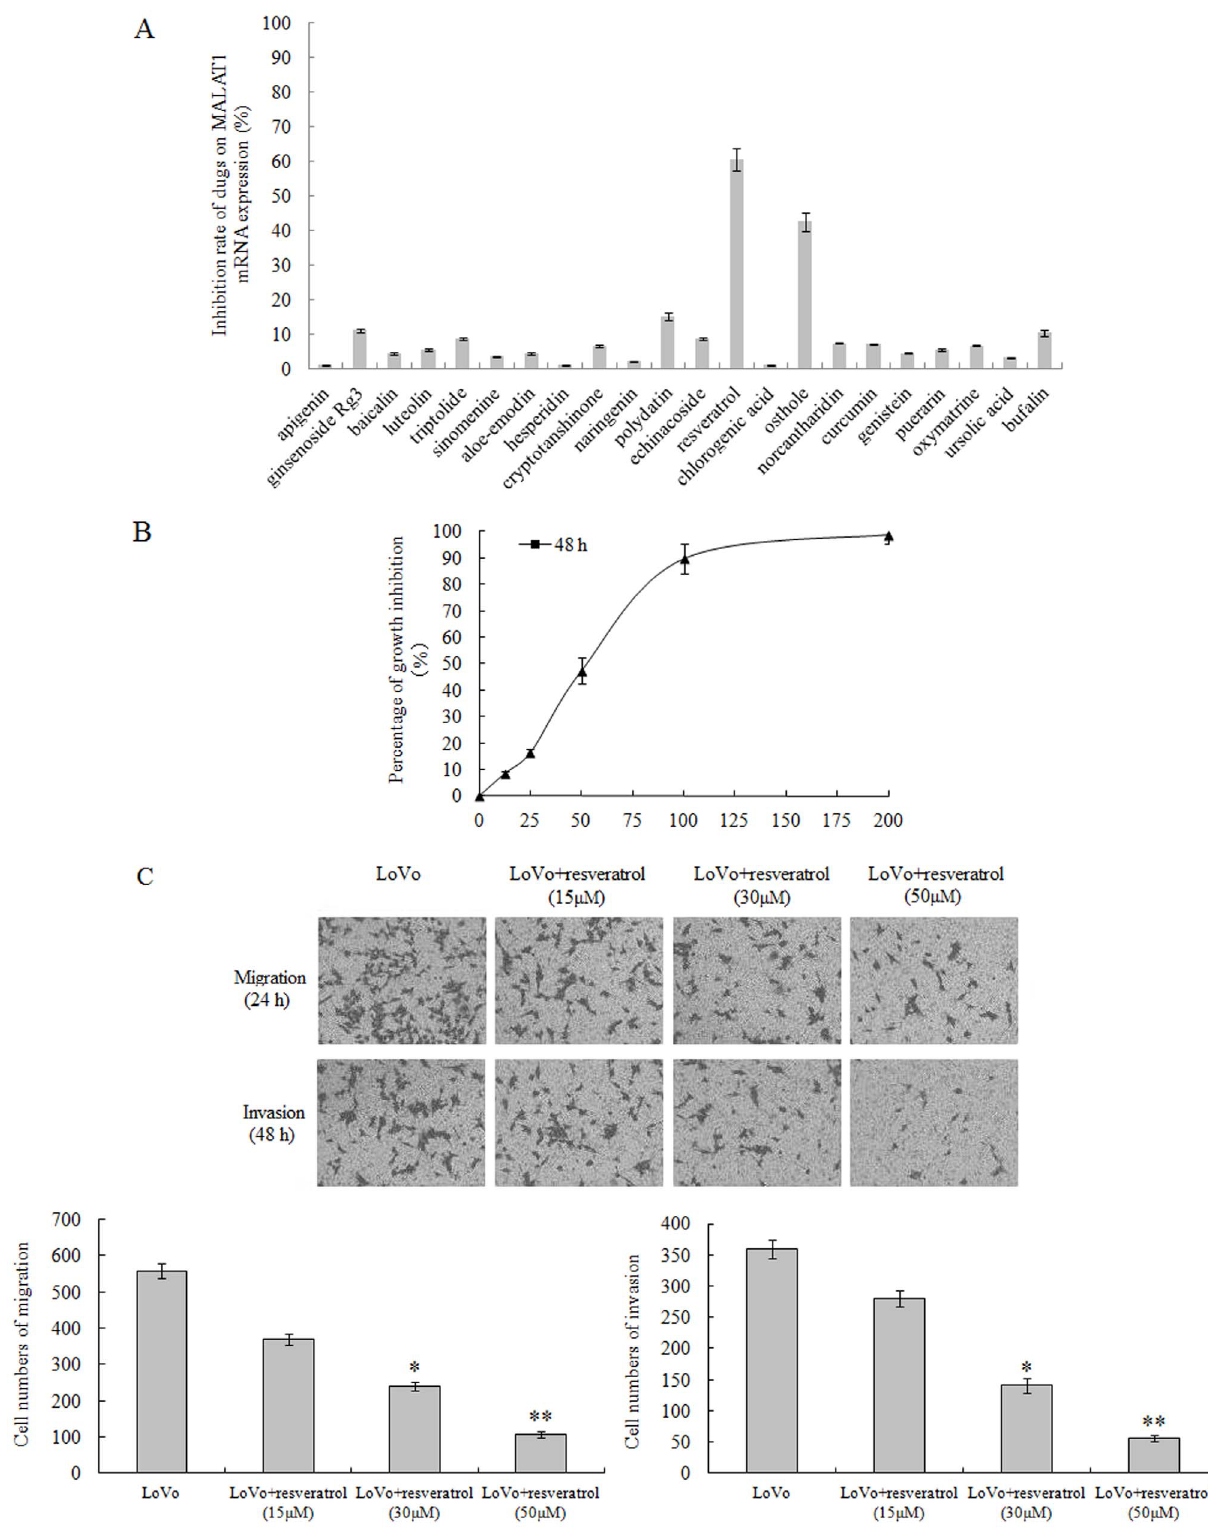
Figure 2. Resveratrol inhibites the proliferation, migration and invasion of CRC LoVo cells. (A): Twenty-two candidate Chinese medicine monomer anticancer drugs were tested for the effective inhibition doses on the MALAT1 expression in LoVo cells. (B): Correlation of resveratrol drug doses and growth inhibition in LoVo cells. Y axis: percentage of growth inhibition; X axis: resveratrol concentrations ( m M). (C): Assessment and quantification of cell migration and invasion of LoVo cells. Values represent the number of migratory/invasive cells per 5 high power fields. * p , 0.05 or ** p , 0.01, compared with control LoVo cells.